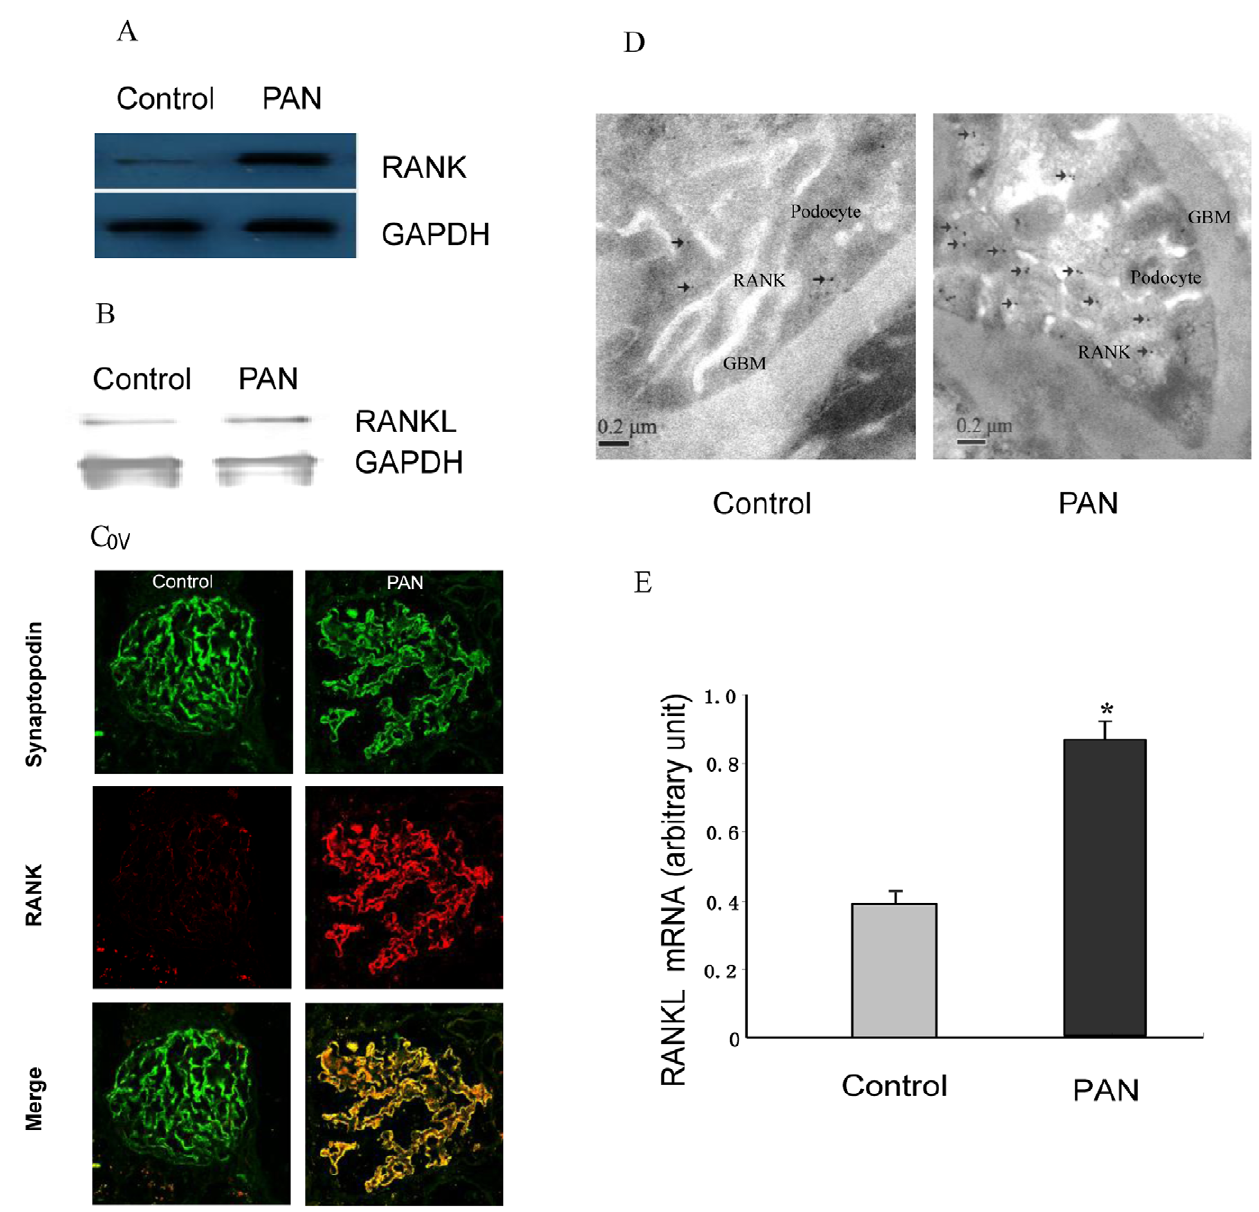
Figure 1. Identification of RANK and RANKL as Upregulation Genes in the Rat Podocyte Injury Model. (A) RANK protein expression was determined by using Western blot analysis with a RANK antibody. GAPDH immunoblotting served as a loading control and confirmed equal protein loading between samples. RANK protein was in low abundance in the rat control. By contrast, RANK increased in PAN models (5.8 6 0.7-fold of controls, n=6, p , 0.01). (B) The levels of RANKL protein increased in PAN rat kidney as compared with control. (C) Induction of RANK was revealed in podocytes in the PAN model using immunofluorescence. RANK expression (red) was low in control glomeruli from rat and colocalized with the podocyte marker synaptopodin (green). In podocytes from animals with PAN, RANK expression was substantially upregulated in podocytes, resulted in a yellow overlap with synaptopodin (Merge). (D) Immunogold analysis of RANK in glomerular walls of normal and PAN rats. RANK was substantially induced in the top of the foot process membrane and the cytoplasm of podocytes in PAN rats. Black arrows mark RANK in podocytes. (E) Induction of RANKL mRNA was upregulated in PAN rats kidney. Quantitative real-time RT-PCR was performed on kidney from PAN rats (2.6 6 0.4-fold of controls, n=6). *Compared with control, p , 0.01. doi:10.1371/journal.pone.0041331.g001 autocrine manner upon PA injury in podocytes, reaching Whole-cell lysates were harvested 24 h or 48 h after PA injury, a maximum after 24 h PA treatment. RANK was confirmed by and RANK protein expression was determined by using Western using Western blot analysis with RANK antibody in SJRH30 cells, blot analysis with RANK antibody. Densitometric analyses which are RANK positive controls (Figure 4E). revealed that RANK was upregulated by 3.8- and 2.4-fold at 24 h and 48 h respectively after PA injury (Figure 4D). RANK immunoblotting revealed that RANK was upregulated in an